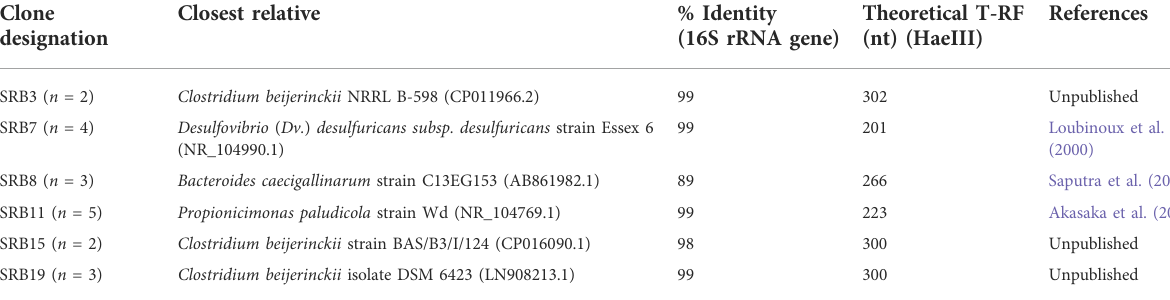
TABLE 3 Identity of cloned bacterial 16S rRNA genes obtained from the sul fi dogenic bioreactor ( n =